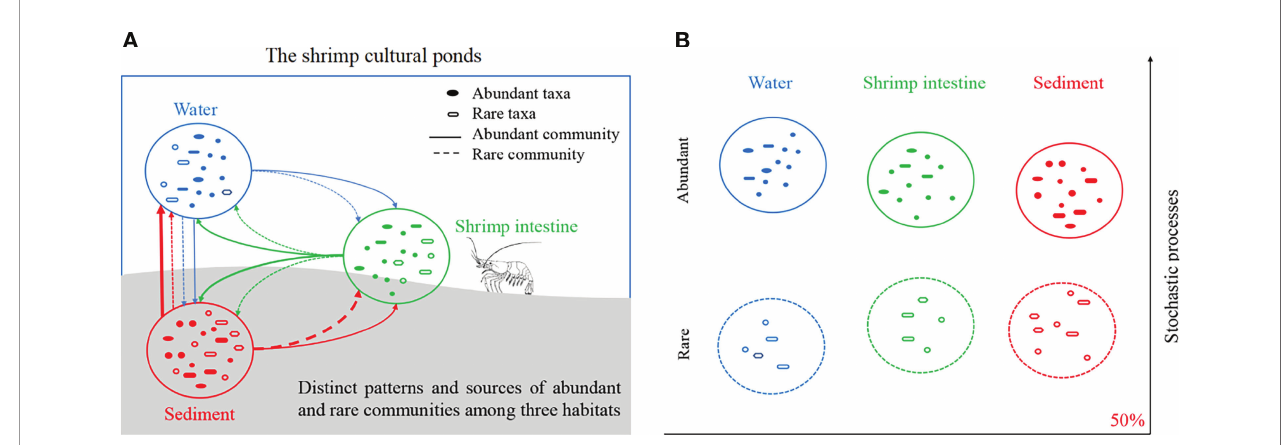
FIGURE 5 | Illustration of community diversity and assembly. (A) Patterns and sources of abundant and rare communities of water/shrimp intestine/sediment habitats in the cultural ponds. (B) Similarities and differences of microbial assembly mechanisms between the abundant and rare communities of